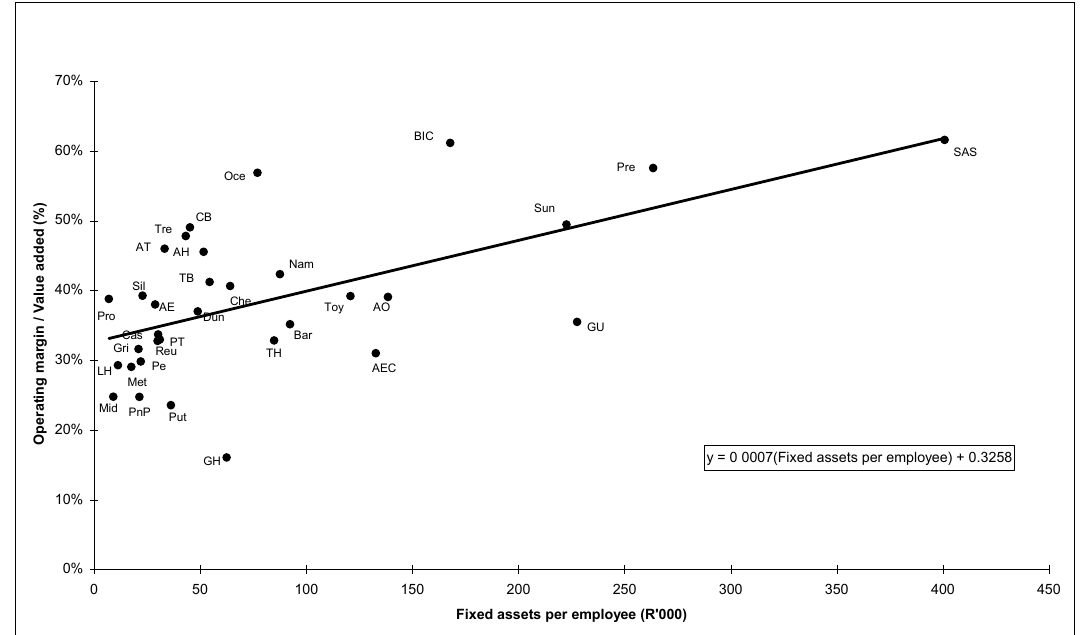
Figure 2: Operating margin as a function of capital intensity per organisation: median Organisations that move along the trend line on either side Table 6: Profit before taxation ÷ are Toyota (South Africa) and Nampak.